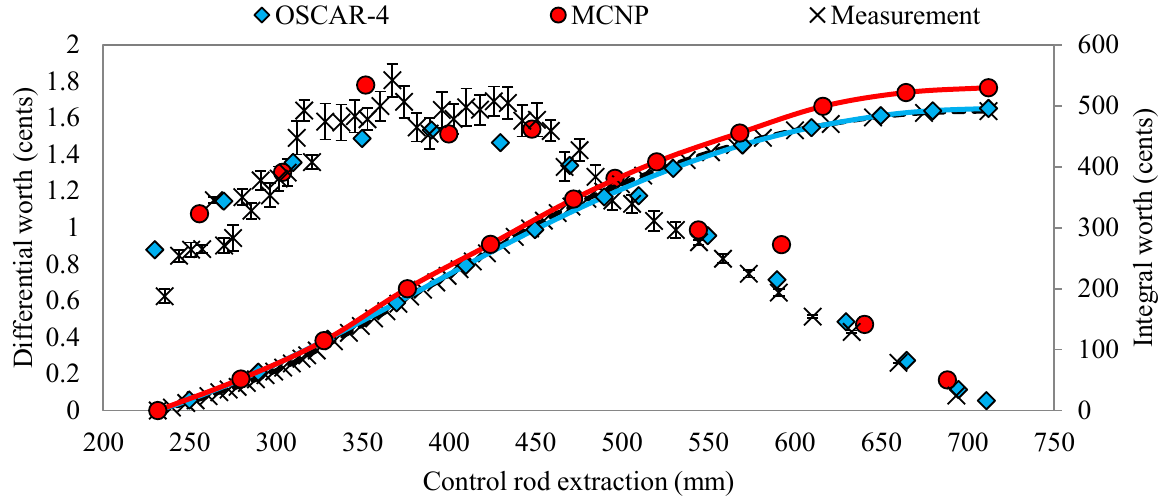
Figure 5. Comparison of the OSCAR-4, MCNP and measured differential and integral worth of control rod S1. The differential worth is represented by scatter plots, while the integral worth is represented by solid line plots. Table II. Integral control rod worth: Comparison of OSCAR - 4, MCNP and measured integral control rod worth for all six control